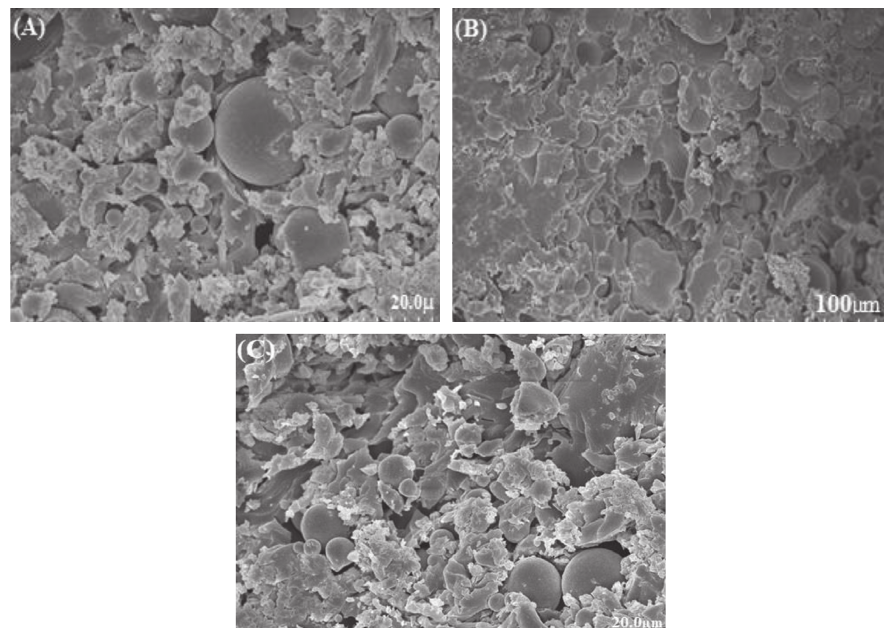
Figure 2: SEM image of epoxy composite material/fly ash: fly ash 40 wt.% ((a), (b)).